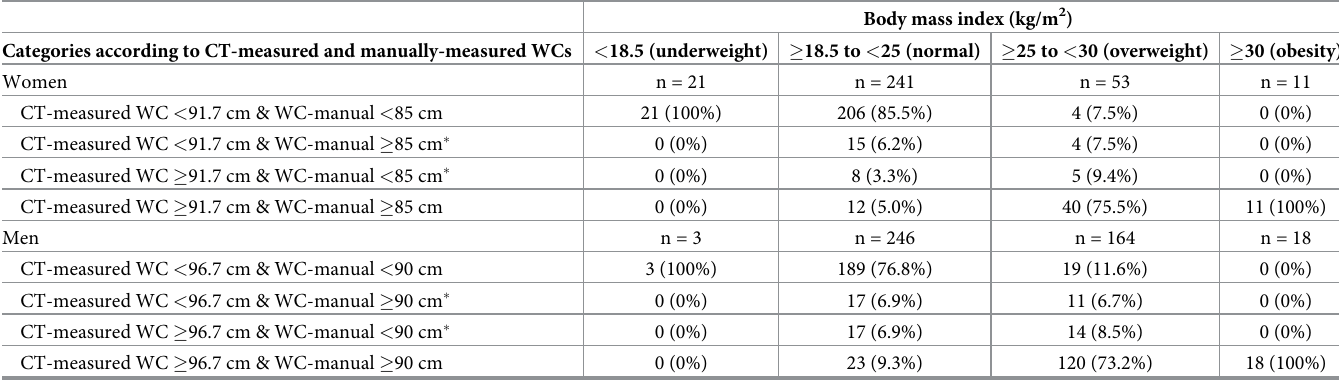
Table 3. Patient categories according to CT-measured and manually-measured waist circumference for each body mass index category.